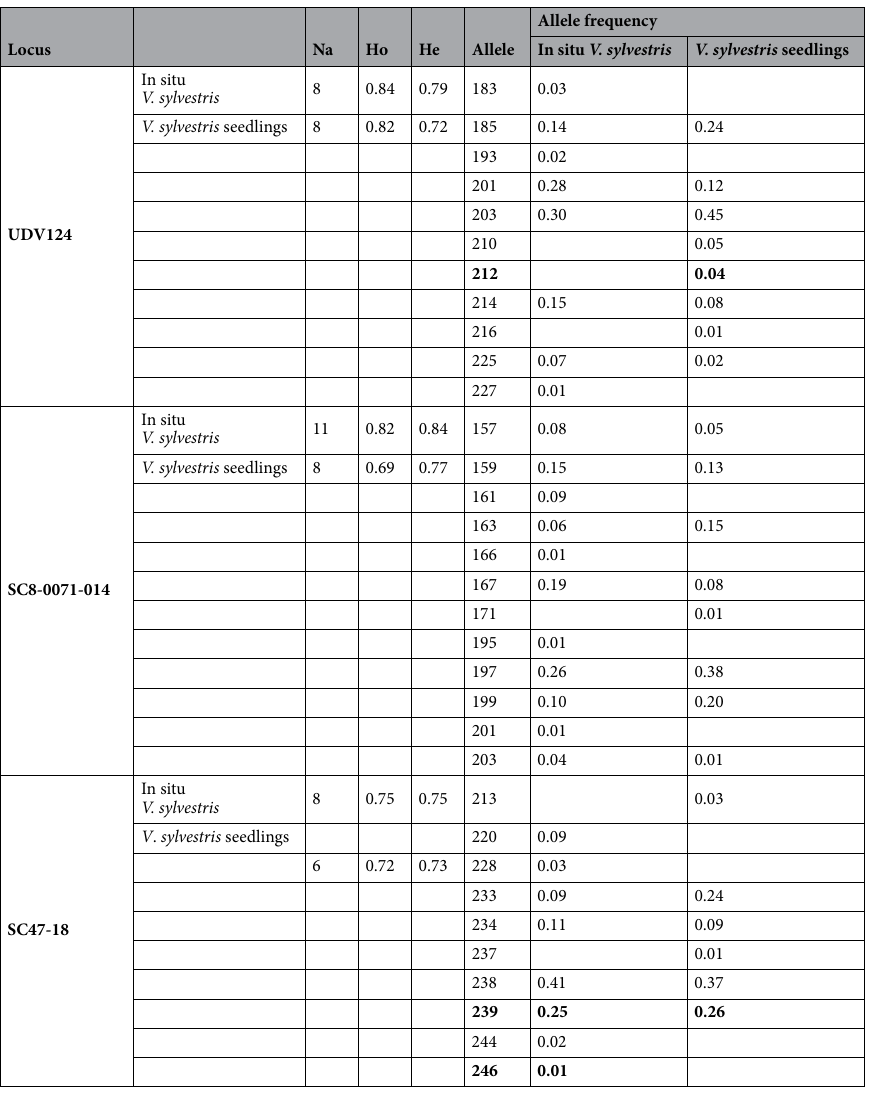
Table 3. Genetic diversity at three SSR markers linked to the Ren1 locus for powdery mildew resistance in V. sylvestris. The alleles in bold are linked to resistance at Ren1 according to Riaz et al. 7,15 . ’Na’ is the number of different alleles, ’Ho’ is the observed heterozygosity, and ’He’ is the expected